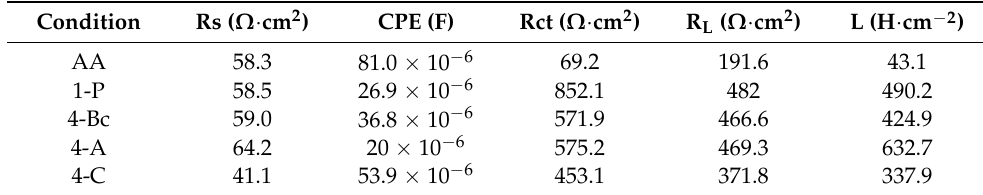
Figure 12. Equivalent circuit used to fit (EIS) data. Table 3. Electrical parameters obtained from fitting the EIS data of the AA condition and ECAP- processed ZK30 Mg